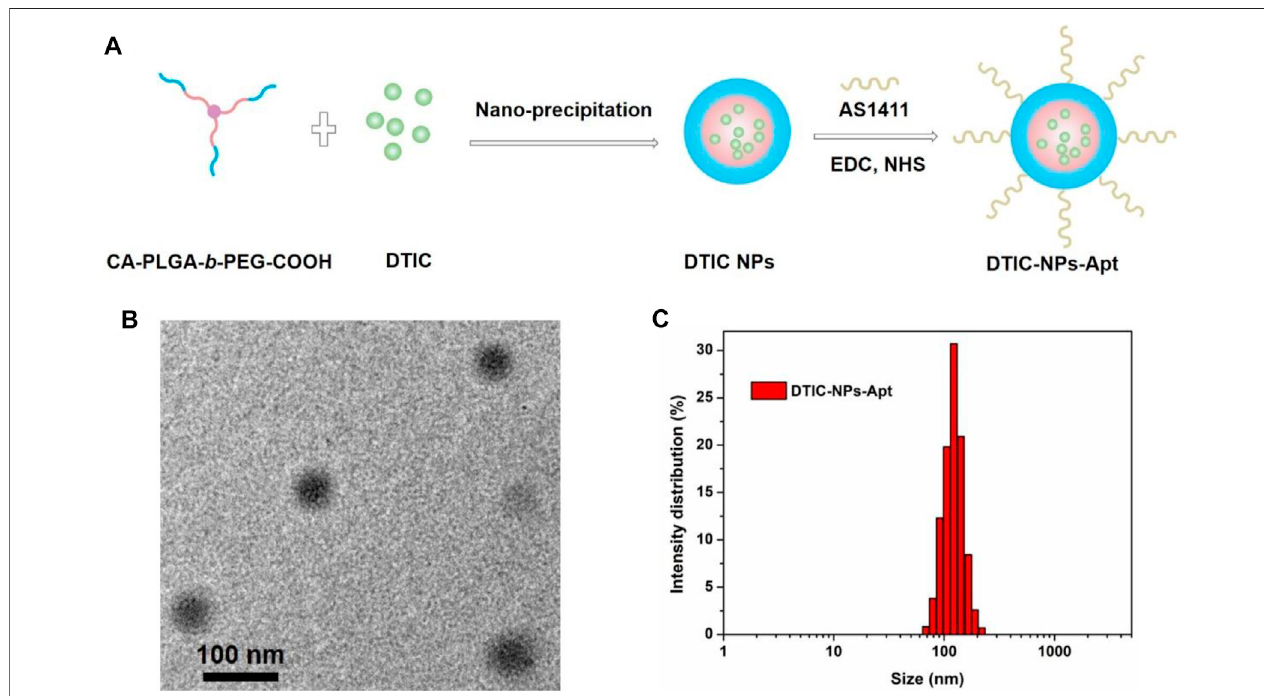
FIGURE 3 | (A) Schematic illustration of the preparation technics for the targeted DTIC-NPs-Apt; (B) TEM image of DTIC-NPs-Apt; (C) DLS size distribution of DTIC-NPs-Apt.